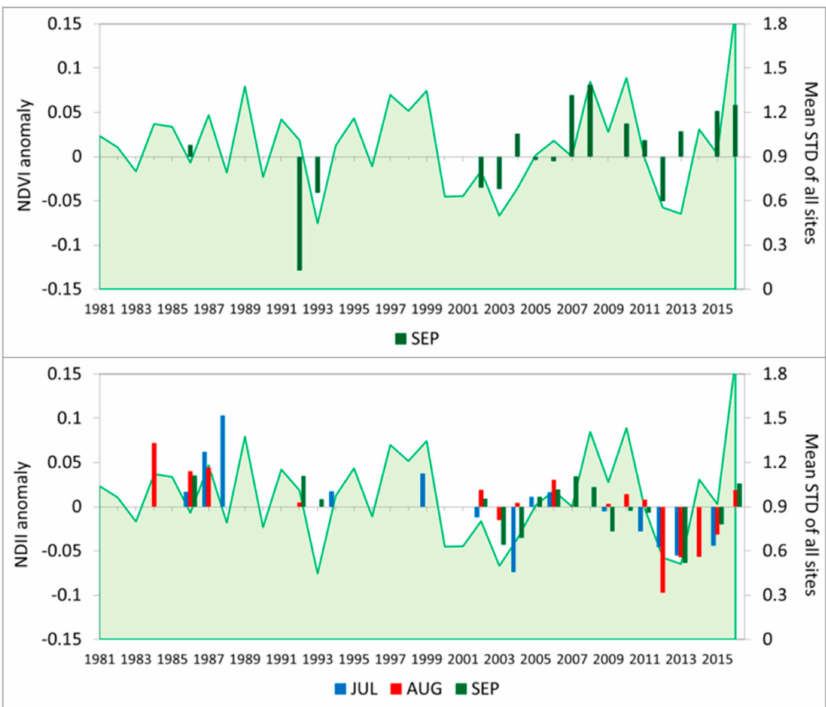
Figure 13. The normalized difference vegetation index (NDVI) (upper chart) and normalized difference infrared index (NDII) (bottom chart) anomalies for selected months and the detrended mean standardized chronology of all sites (light green